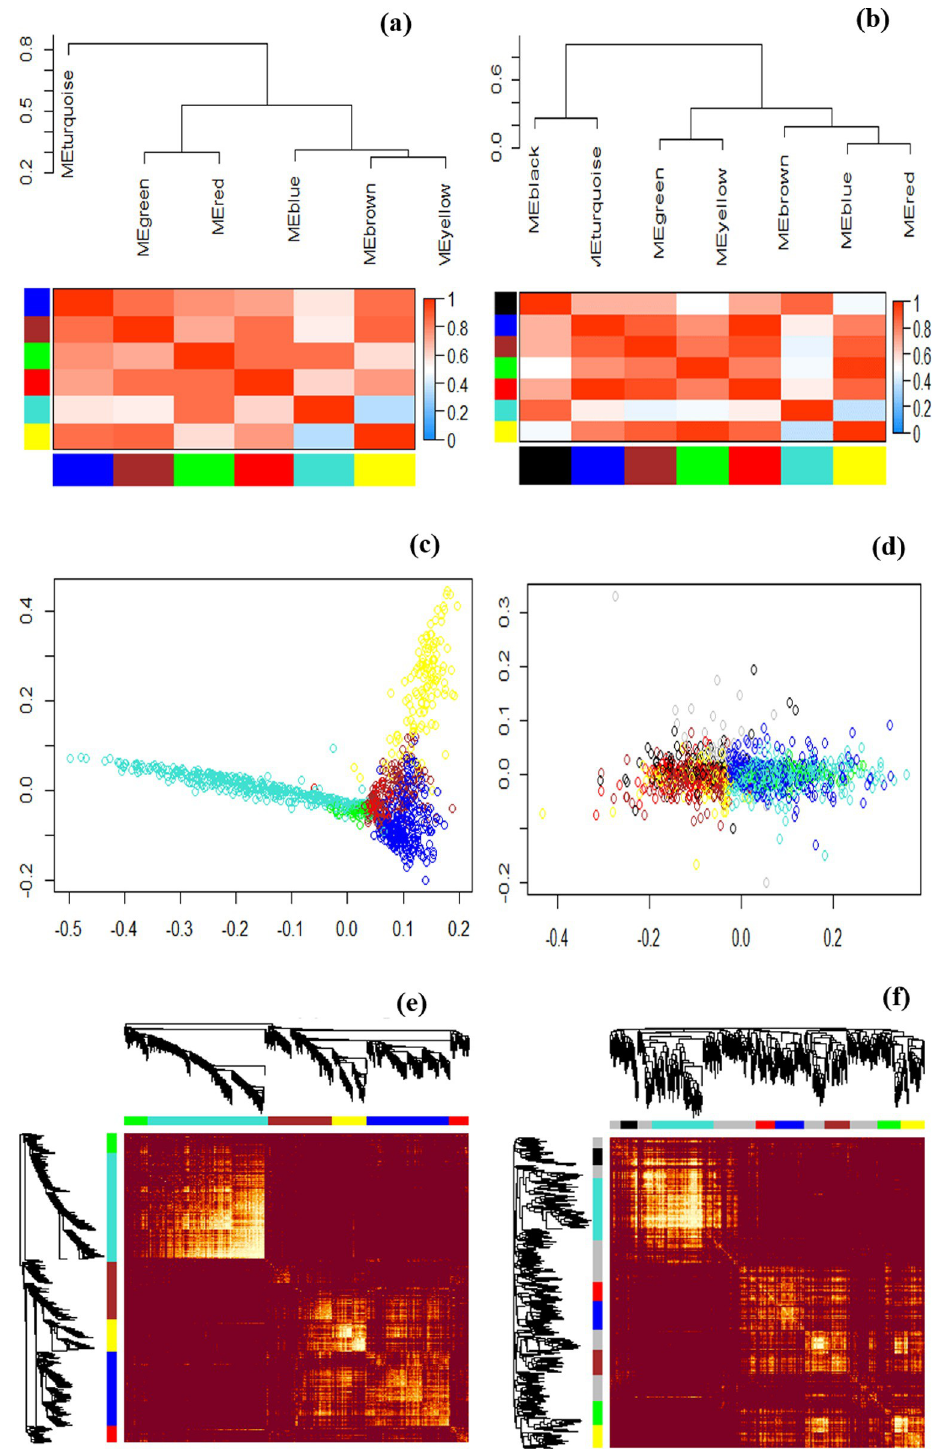
Fig 5. Co-expression analysis and modules identification. a, b) The module eigengene adjacency is showed by hierarchical clustering and heat map. In the heatmap, each row and column correspond to a specific module’s eigengene was denoted by module color. Within the heatmap, red indicates high adjacency (positive correlation) and blue shows low adjacency (negative correlation) as shown by the color legend. A module eigengene summarizes the gene expression profile of each module for (a) biotic and (b) hormonal studies. In the heatmap of module-module